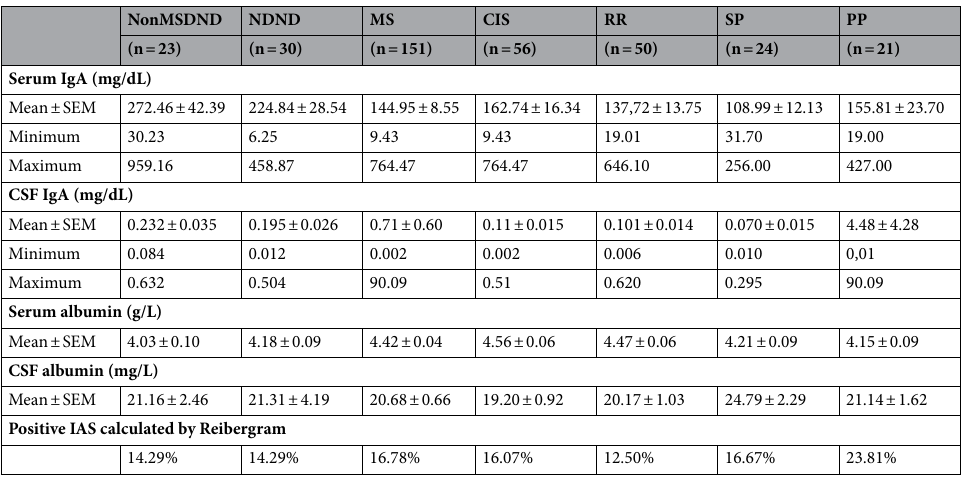
Table 2. Analysis of the IgA concentration in CSF and serum samples from MS patients and control groups. NonMSDND Non-MS demyelinating neurological diseases, NDND non-demyelinating neurological diseases, MS multiple sclerosis patients, CIS clinically isolated syndrome, RRMS relapsing–remitting multiple sclerosis, SPMS secondary progressive multiple sclerosis, PPMS primary progressive multiple sclerosis, SEM standard error of the mean, IAS intrathecal IgA